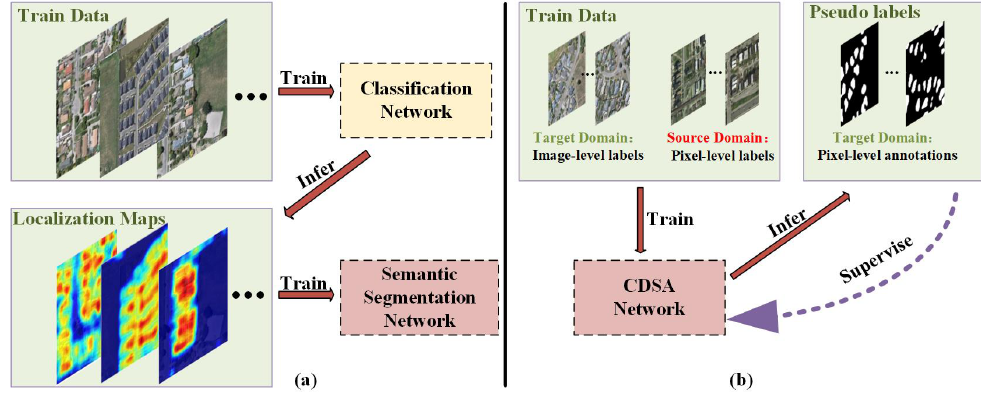
Figure 1. ( a ) A popular weakly supervised segmentation route is to train a classification network with single domain information, from which class activation maps are derived as pseudosupervision information for further supervising segmentation network training. ( b ) Our CDSA segmentation network mines cross-domain structure affinity as context for weakly annotated data to benefit pseudolabel inference and object